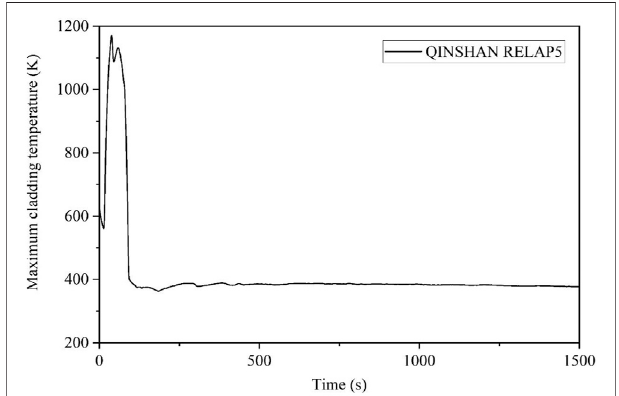
FIGURE 11 | Double-ended CL LBLOCA maximum cladding temperature.